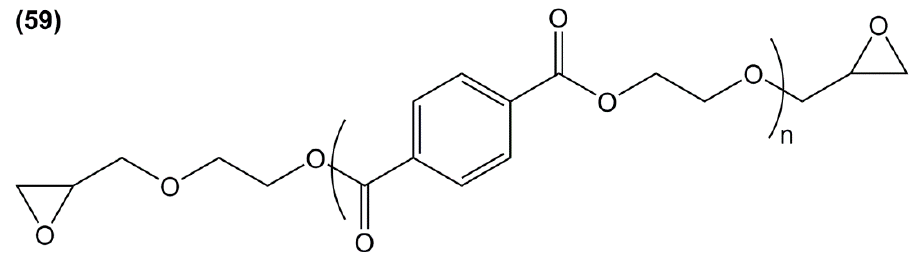
Figure 32. Epoxy monomers obtained from glycolyzed PET waste by Czub [203].